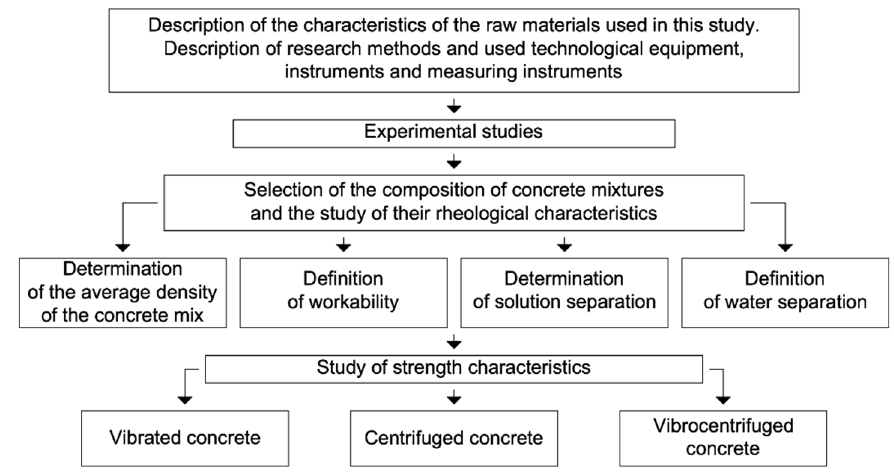
Figure 2. Plan of experimental studies.